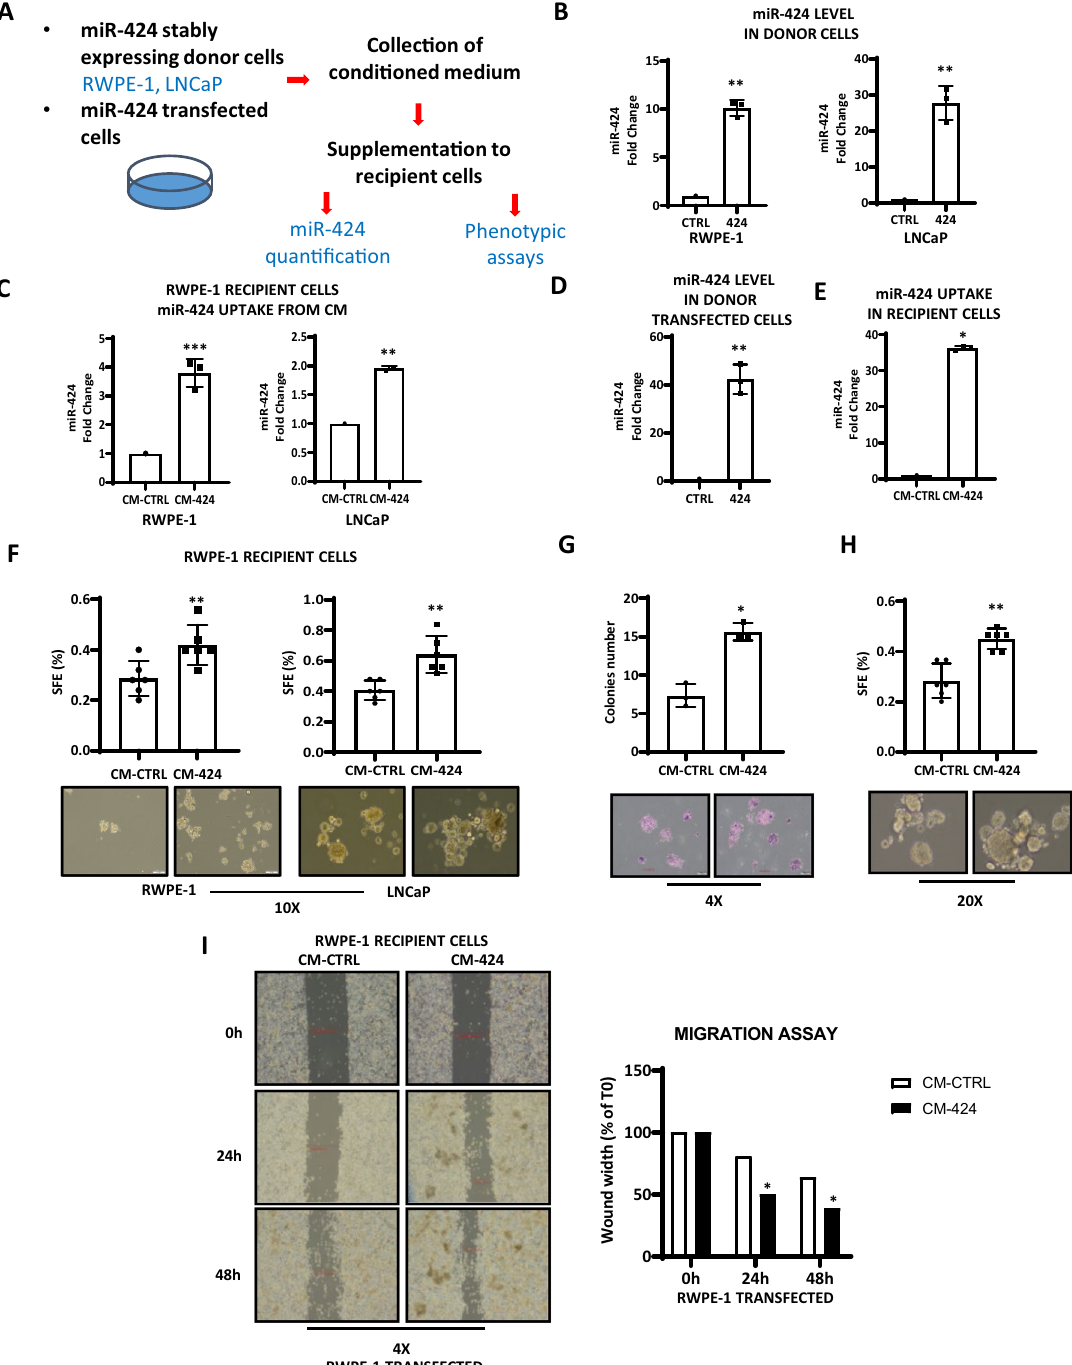
Fig. 2 Paracrine impact of secreted miR-424. A Experimental design for phenotypic analysis. B miR-424 levels in RWPE-1 and LNCaP donor cells stably expressing miR-424 or control plasmid. C miR-424 levels in recipient cells (RWPE-1) and (LNCaP) following the addition of conditioned medium (CM) from donor cells with (CM-424) or without (CM-CTRL) stable expression of miR-424. D miR-424 level in RWPE-1 cells transfected with pre-miR-424 (424) or negative control pre-miRNA (CTRL). E miR-424 transfer in recipient RWPE-1 cells following incubation with CM from control or pre-miR-424 transfected RWPE-1 cells. F Tumor-sphere forming ef fi ciency (SFE) of RWPE-1 recipient cells incubated with CM from RWPE-1 and LNCaP donor cells with (CM-424) or without (CM-CTRL) miR-424 expression. G and H Colony ( G ) and tumor-sphere formation ( H ) after supplementation of CM from control or pre-miR-424 transfected RWPE-1 cells. Representative images are shown at bottom of panels F and G . I Cell migration capacity measured in wound- healing assay of RWPE-1 cells after supplementation of CM from control and pre-miR-424 transfected RWPE-1 cells. Right: quanti fi cation of wound width closure percentage. * p ≤ 0.05, ** p ≤ 0.01 by two-tailed Student ’ s t